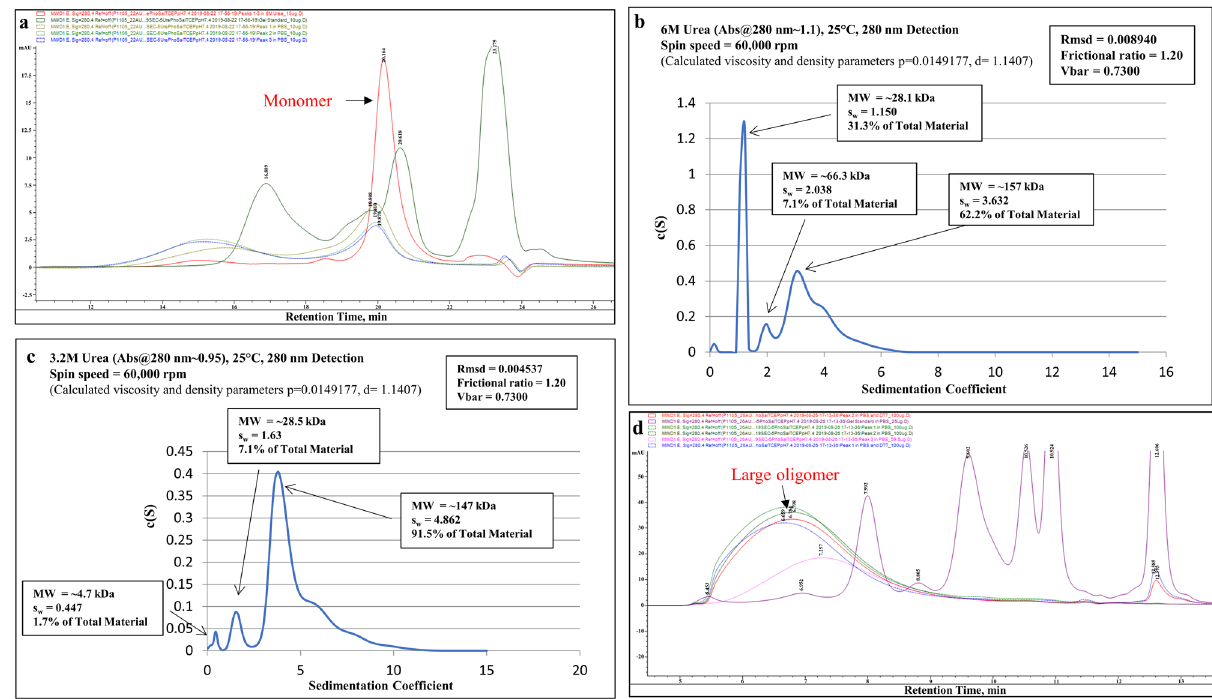
Fig. 1 Characterization of the bulk AV-1980R product during manufacturing. a size exclusion chromatography (SEC) analysis of the AV- 1980R protein in 8 M urea in the mobile phase. b Analytical ultra-centrifugation (AUC) pro fi les of the protein in 6 M urea. c AUC pro fi les of the protein in 3.2 M urea. d SEC analysis of the protein with no urea in the mobile